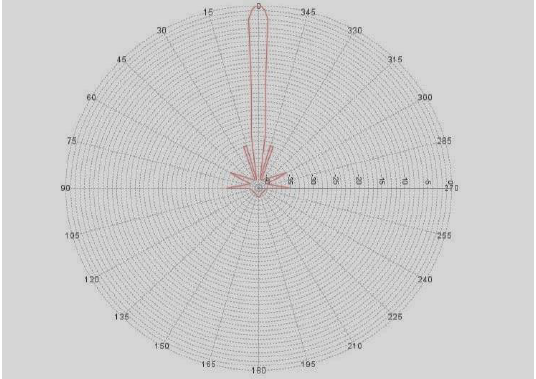
Fig. 4. Cosecant squared antenna pattern used in SEAMCAT (horizontal pattern).